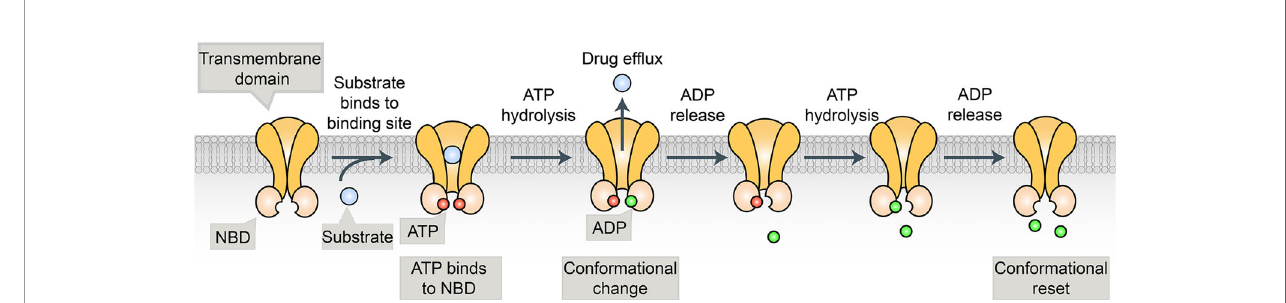
transporters that were fi rst reported as multidrug ef fl ux pumps, including ABCB1 [P-glycoprotein/P-gp/MDR1), ABCG2 (BRCA Resistance Protein/BCRP), and ABCC1 (multidrug resistance protein 1(MRP1)] (5, 6).